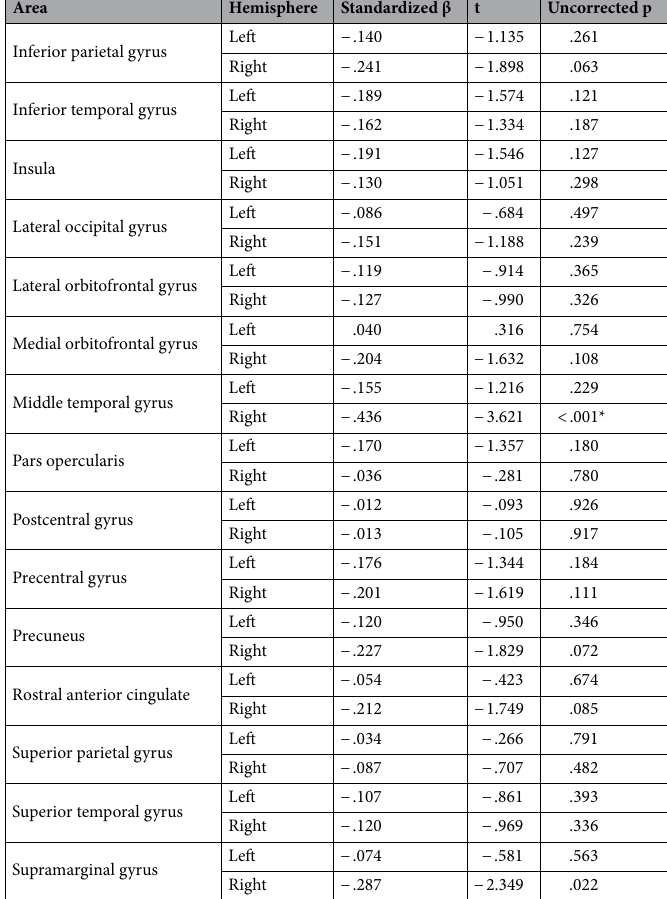
Table 2. The associations between proprioceptive drift index and cortical thickness. All estimates were controlled for age, sex and intracranial volume. * Survived the Benjamini–Hochberg procedure (FDR was set at